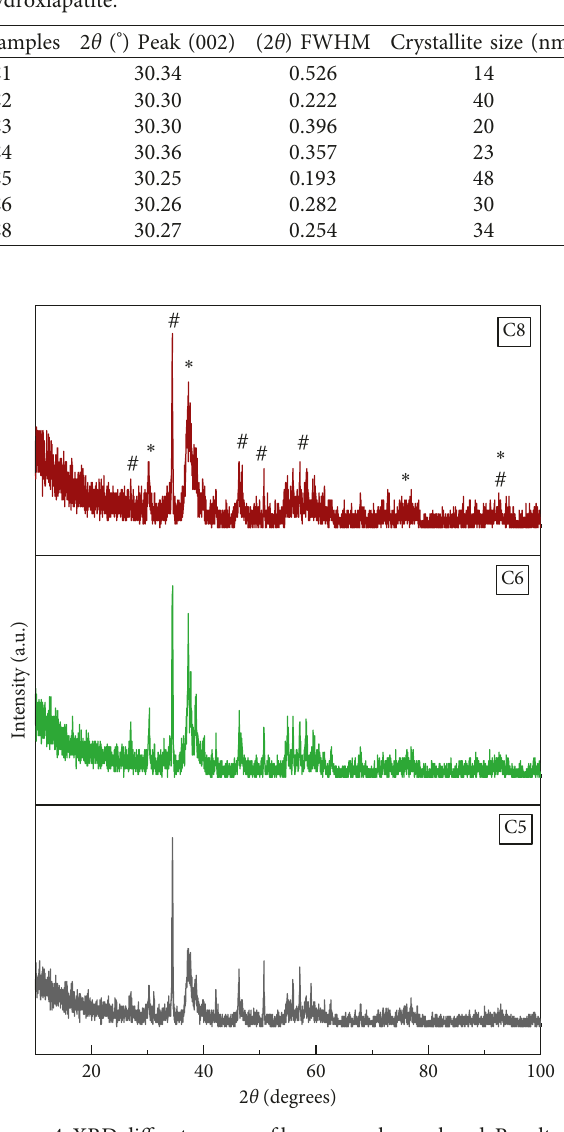
Figure 4: XRD diffractograms of bone samples analyzed. Results of the samples from the layers C5, C6, and C8, where peaks of hy- droxyapatite ( ∗ ) (Ca 10 (OH) 2 (PO 4 ) 6 ) and calcite (#) (CaCO 3 ) are observed.